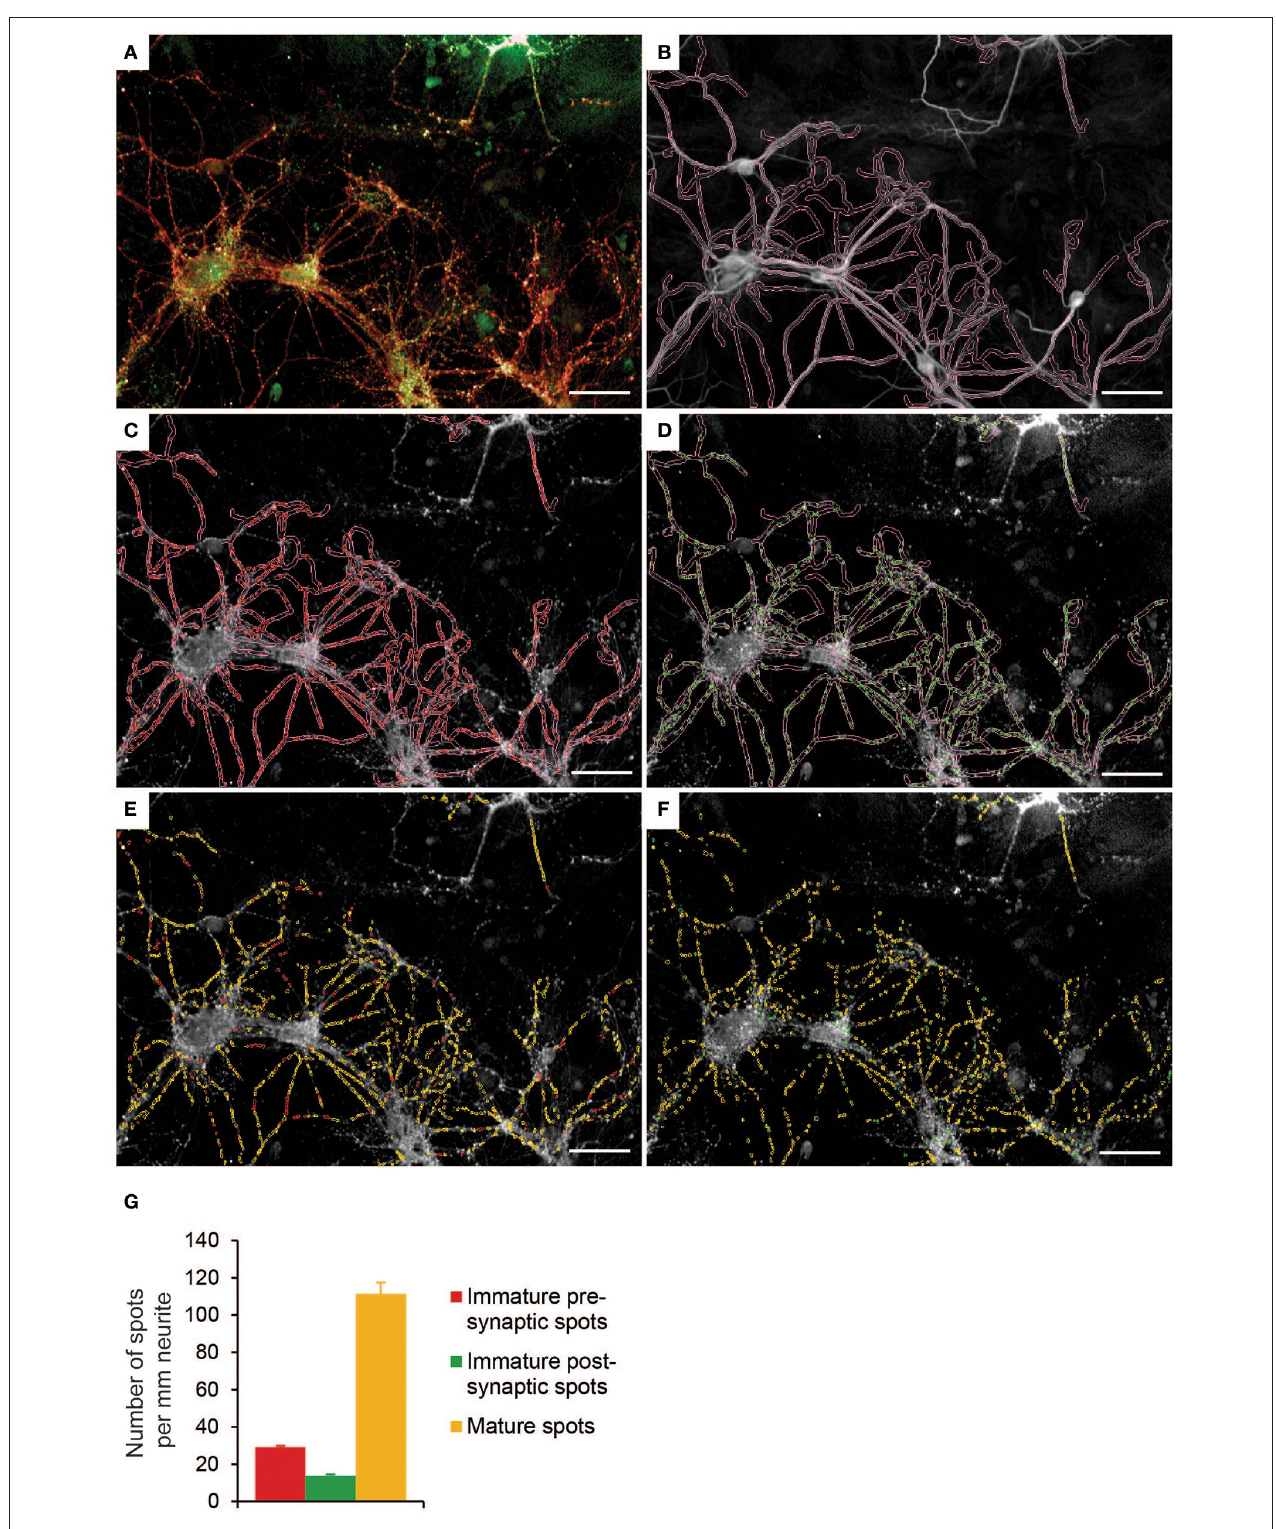
FIGURE 5 | Synapse detection in a primary neuron-astrocyte co-culture using Columbus software. (A) Example image of control condition showing presynaptic spots (red) and postsynaptic spots (green). (B) Resized neurites. (C) Detection of presynaptic spots. (D) Detection of postsynaptic spots. (E) Presynaptic spots are categorized into either immature spots (red) or mature spots (yellow). Spot is mature when pre- and post-synaptic spots are in close proximity (2px). (F) Postsynaptic